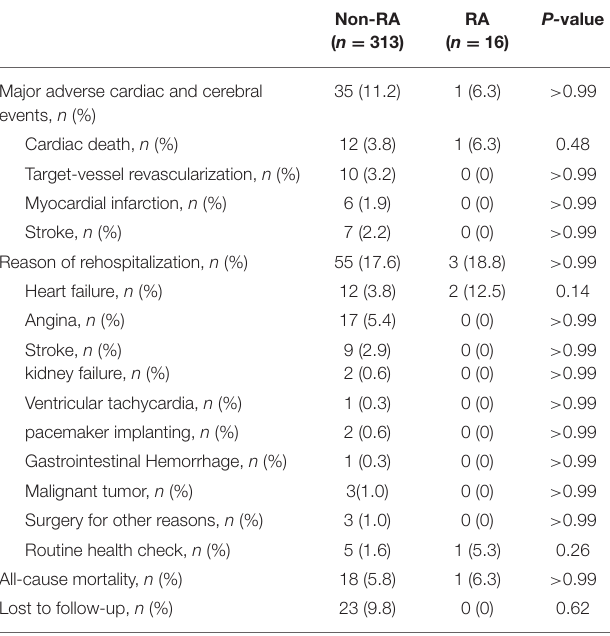
TABLE 5 | Clinical outcomes on